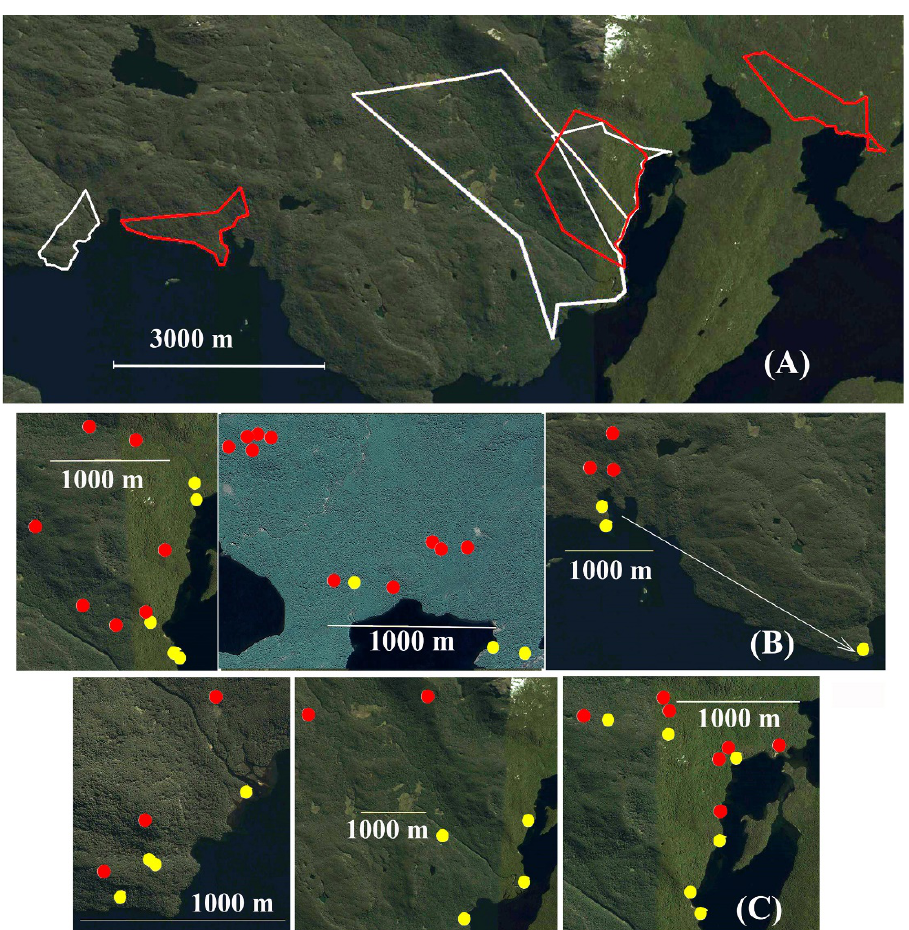
Figure 3. ( A ) Annual home ranges of 3 male (red) and 3 female (white) huemul in the Protected Park Shoonem. Precise locations in winter (yellow) and summer (red) of 3 male ( B ), and of 3 female huemul ( C ). Arrow indicates one unusual displacement in late winter, which ended in death by starvation.